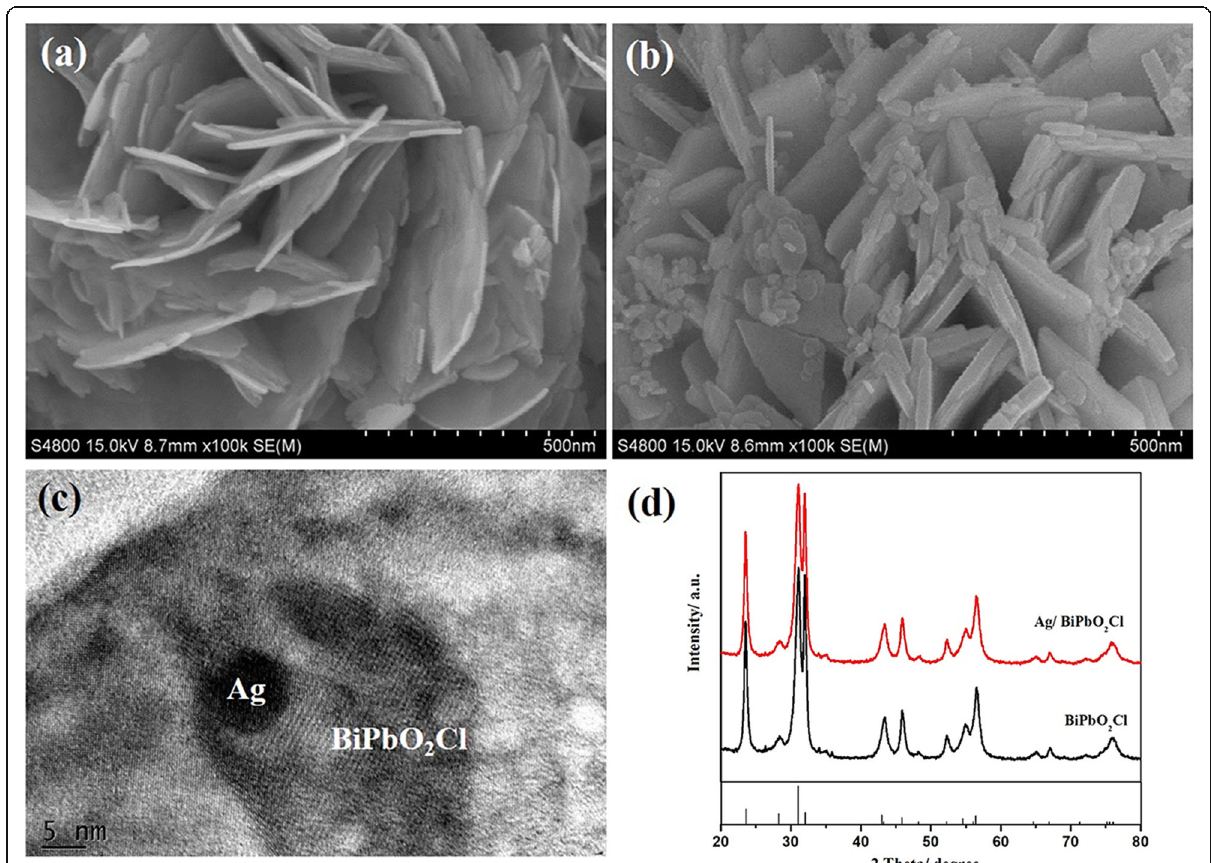
Fig. 2 The SEM of BiPbO 2 Cl ( a ) and 0.5 wt% Ag/BiPbO 2 Cl composites ( b ). c High-resolution TEM image of the 0.5 wt% Ag/BiPbO 2 Cl composites. d XRD of